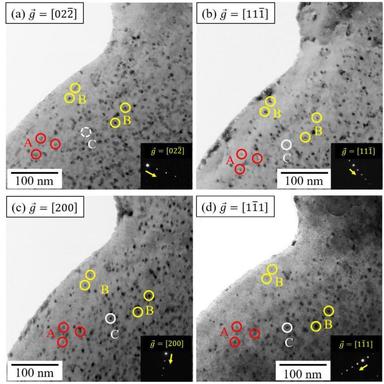
Kinematic bright field images of ThO2 after 0.47 dpa proton irradiation at 600oC obtained using zone and various g conditions: (a) , (b) , (c) , and (d) .